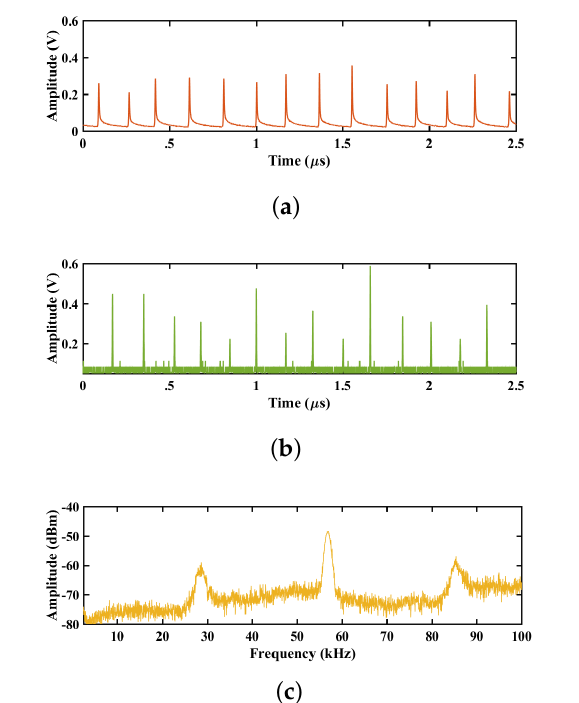
Figure 8. Time series and frequency spectra of the emission laser without modulation. ( a ) Time series of the 1064 nm wavelength emission. ( b ) Time series of the wavelength radiation of 532 nm. ( c ) Spectrum frequency of the emission of 532 nm.